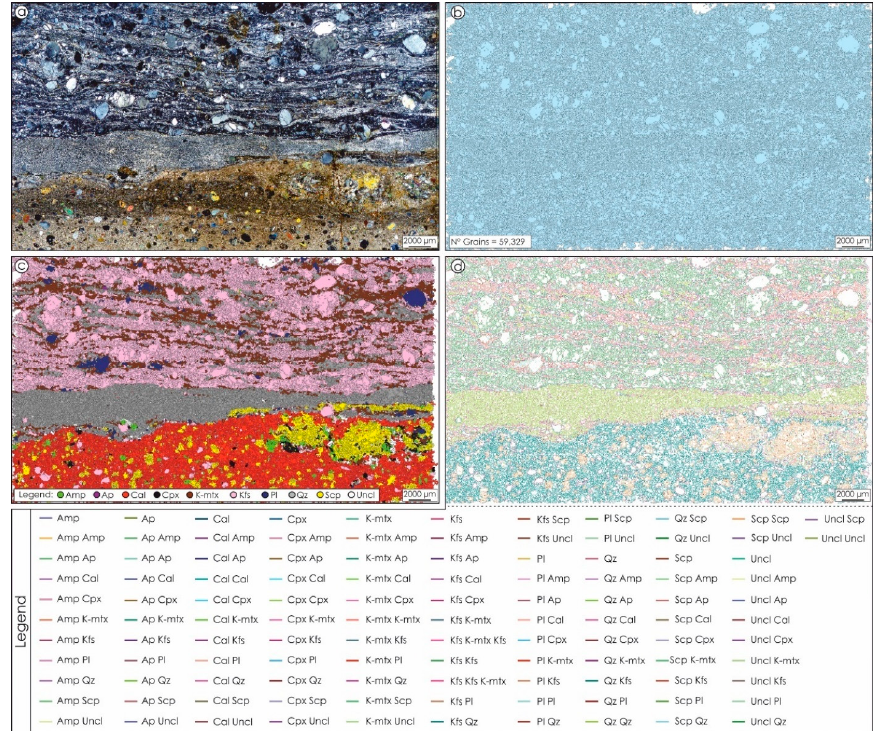
Figure 9. Mylonitic tonalite outputs of the Micro-Fabric Analyzer: ( a ) the thin section optical image (38.4 × 22.2 mm 2 in size with a pixel size of 5.29 μ m); ( b ) output of the GSD tool; ( c ) output of the Min-GSD tool; ( d ) map of couples of mineral contacts. Mineral abbreviations from [46]. Uncl = Unclassified phase; K-mtx = potassium-rich matrix.